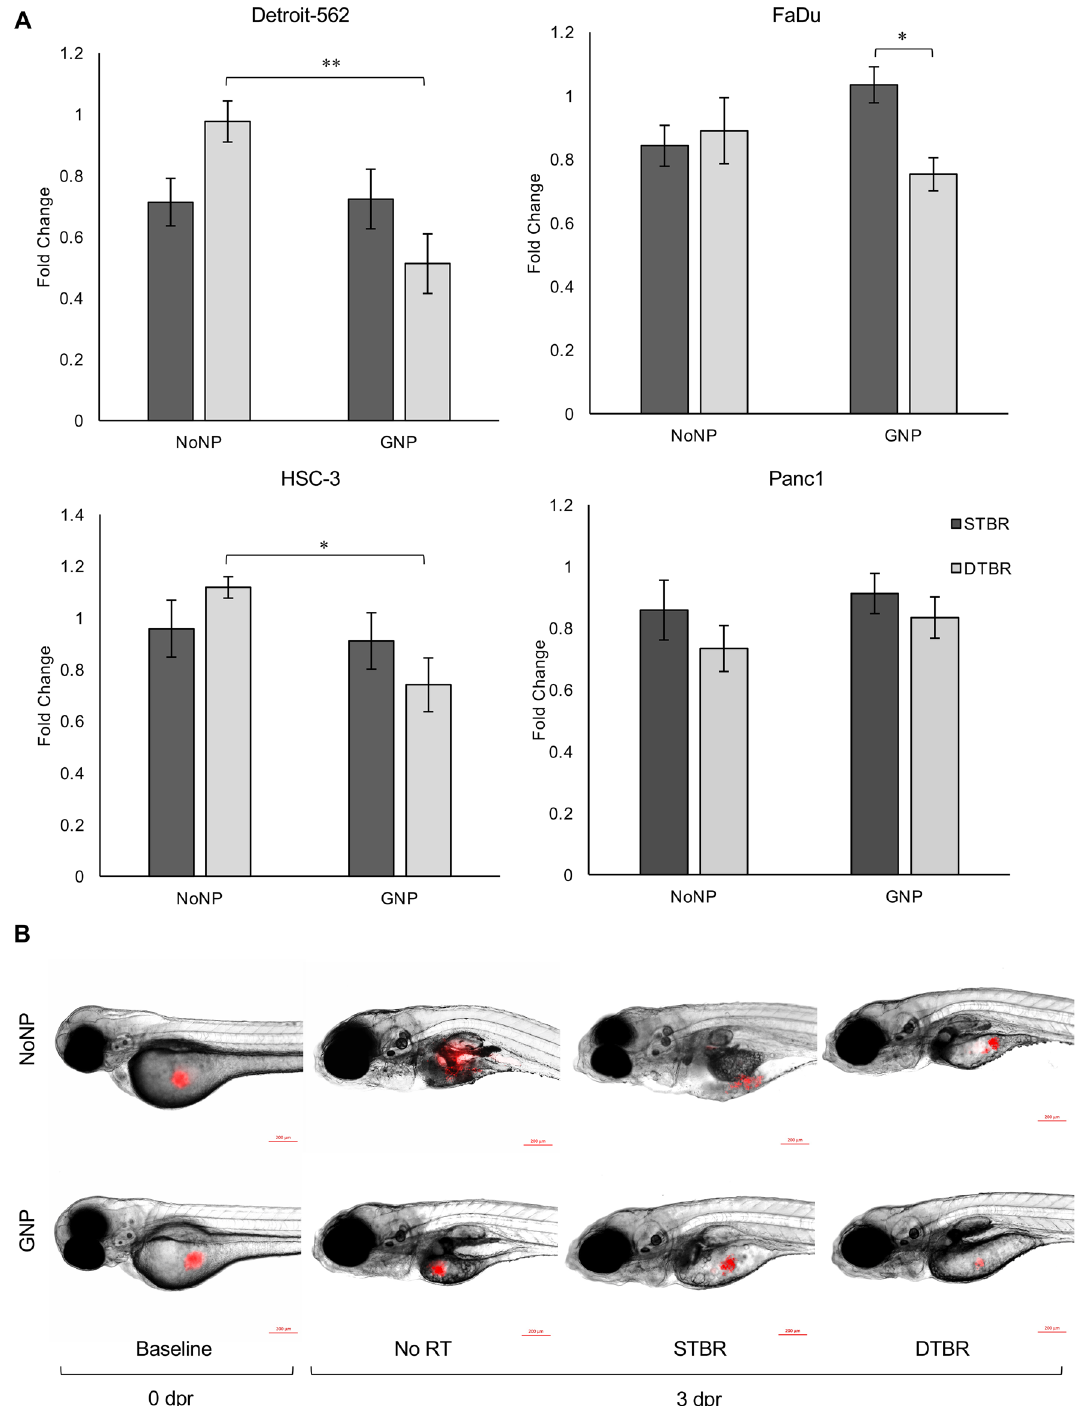
Figure 4. GNP-mediated DTBR significantly decreased HNCC proliferation in vivo. Groups of 15–20 zebrafish larvae were used for each time point and treatment group, 50–100 cells were injected into the yolk sac of each fish, and the number of fluorescent cells was quantified ex vivo. Xenografted cells were quantified at baseline (0 days post radiation (dpr)) and 3 dpr after treatment with 8 Gy from the STB or DTB. Results are represented as fold change of the unirradiated control cells (No RT). ( a ) With GNP-DTBR, Detroit-562 and HSC-3 xenografted cells demonstrate increased cell death compared to NoNP-DTBR (p = 0.005 and p = 0.015, respectively), and FaDu cells exhibit increased cell death compared to GNP-STBR (p = 0.022). There were no significant differences in Panc1 cancer cell proliferation between treatment groups in vivo. ( b ) Representative images of fluorescently labelled HSC-3 HNCCs injected into the yolk sac of casper larvae, scale bars are 200 µM. Results are presented as fold change means ± standard error of the mean, p* < 0.05, p** < 0.01, p*** < 0.001 for significant decreases in in vivo cell proliferation. Significance between groups was tested using one-way analysis of variance (ANOVA) with a Tukey multiple comparisons test (n = 3; 20 larvae per group/replicate). GNP gold nanoparticles, NoNP no nanoparticles, HNCC head and neck cancer cells, STB(R) standard target beam (radiation), DTB(R) diamond target beam